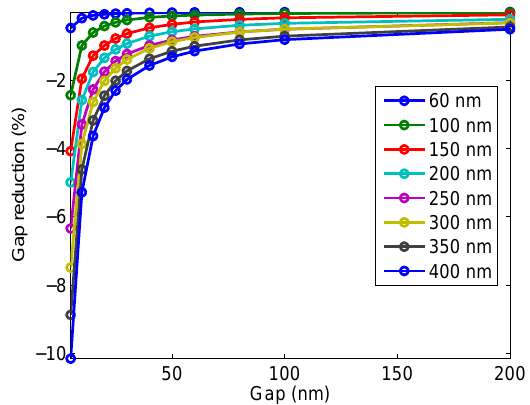
Figure 6: Gap reduction after illumination in percents as a function of the initial gap (in nm).